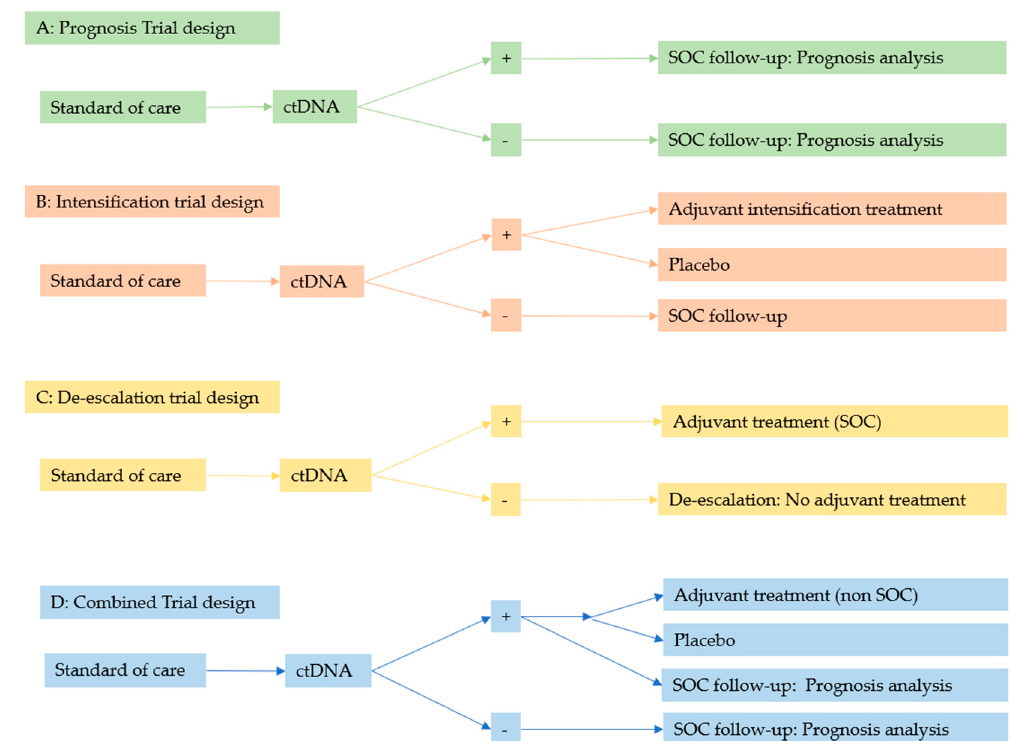
Figure 2. Trial designs based on ctDNA detection. SOC: Standard of